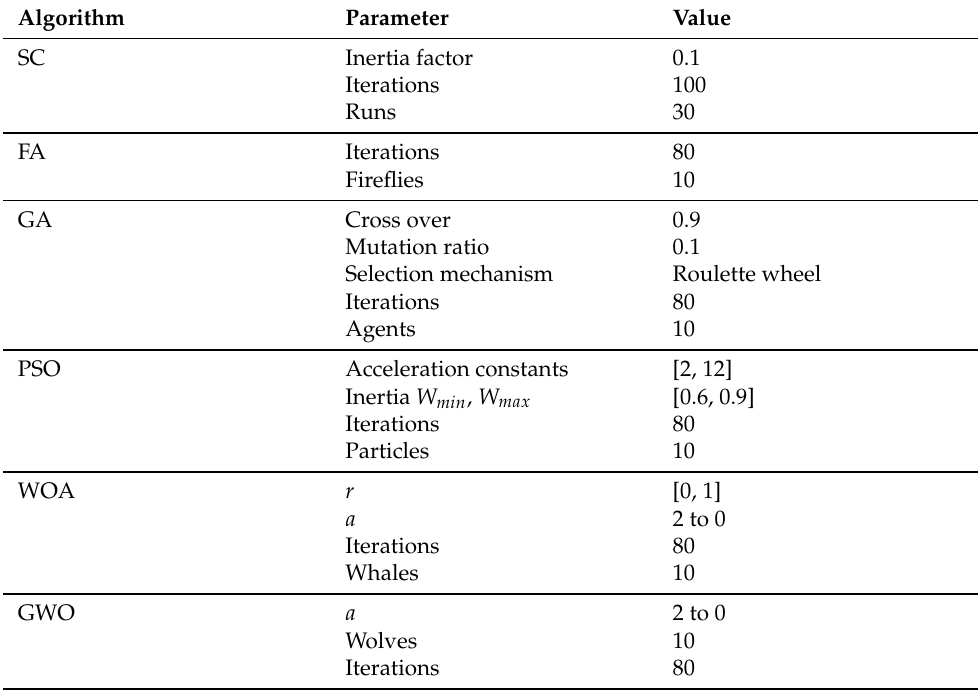
Table 4. Configuration parameters of the competing